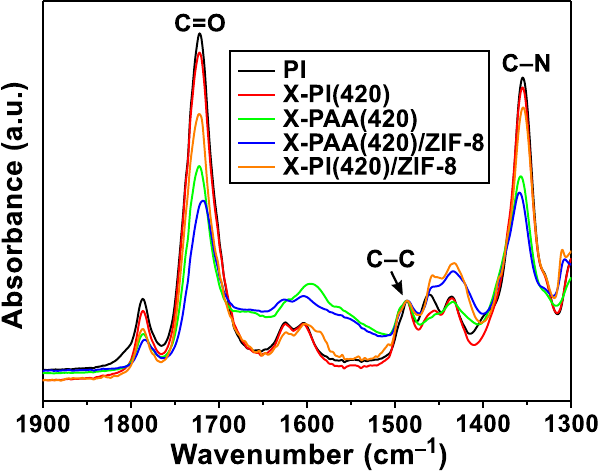
Figure 3. FT-IR spectra of the X-PI(420) sample at each polymer modification step in comparison with that of the pristine PI.